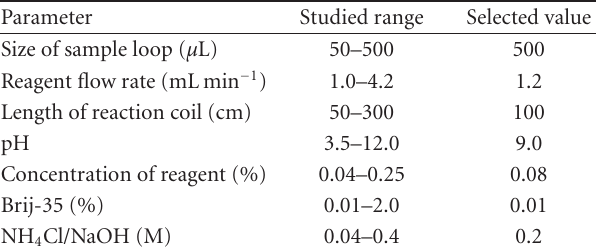
Table 1: Selected chemical and FIA parameters obtained with optimization experiments.